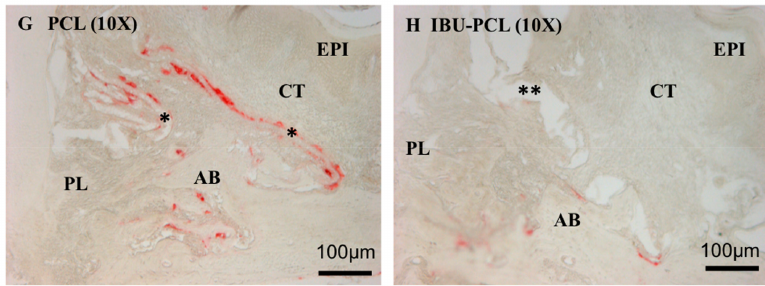
Figure 6. Periodontal wound healing at 22 days. Corresponding histological sections scaling and root planning (SRP) ( A ), IBU-PCL ( B , D ), and PCL ( C , E ). Red lines = cemento-enamel junction (CEJ); green lines = epithelial attachment level; yellow lines = bone level. PCL and the IBU-PCL membrane are highlighted (*). Histomorphometric analysis ( F ). EA and BL have been measured on histological sections. Distances are expressed as the mean ± SD in µ m; * p < 0.05. TRAP expression: Few TRAP-positive cells (red staining) were observed on the bone surface at 22 days ( G , H ). Numerous TRAP-positive cells were observed around PCL membrane (*), but not around the IBU-PCL membrane (**). EPI: gingival epithelium, CT: gingival connective tissue, AB: alveolar